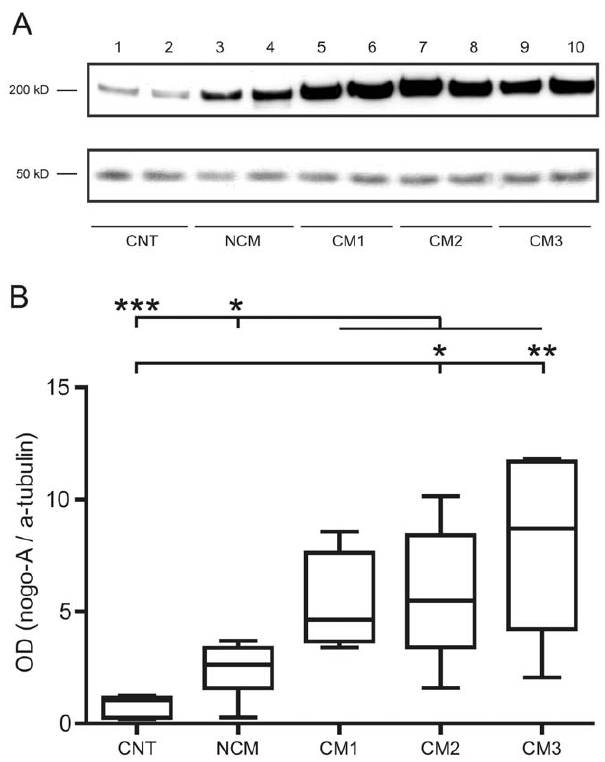
Figure 1. Representative Western blot (A) for Nogo-A (200 kDa) and alpha-tubulin (50 kDa) and densitometric analysis of western blot experiments (B) in mice with different stages of cerebral malaria (mild, CM1 n=4; moderate, CM2 n=9; severe CM3 n=6), infected mice without neurological involvement (NCM n=6) and uninfected control animals (CNT n=5). A significant increase of densitometric measures for Nogo-A was observed in animals with CM compared to NCM and non-infected control animals. Comparing subgroups of animals with different clinical levels of severity CM2 and CM3 mice showed significantly higher Nogo- A levels compared to CNT mice. ***, p . 0.001; **, p . 0.01; *, p , 0.05.